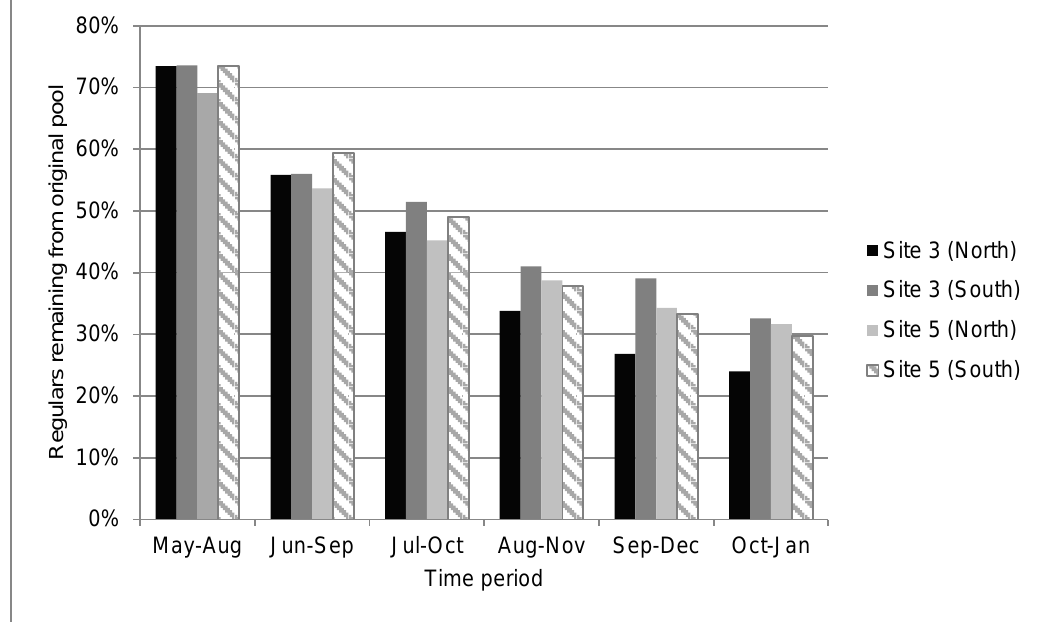
Figure 8. Decay rate of regular vehicles (N ≥ 30, σ≤